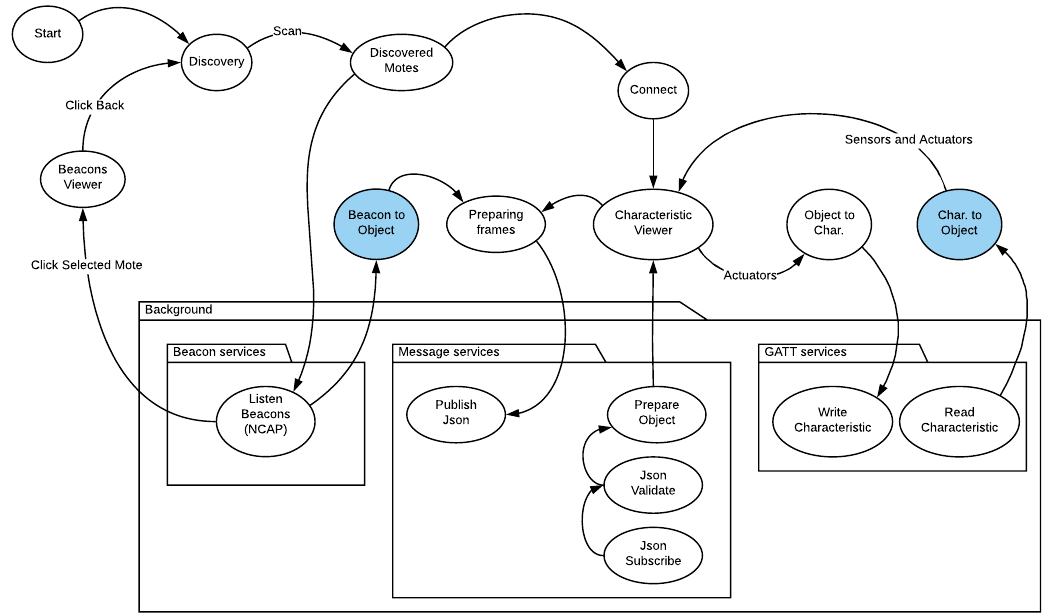
Figure 13. The NCAP basic state